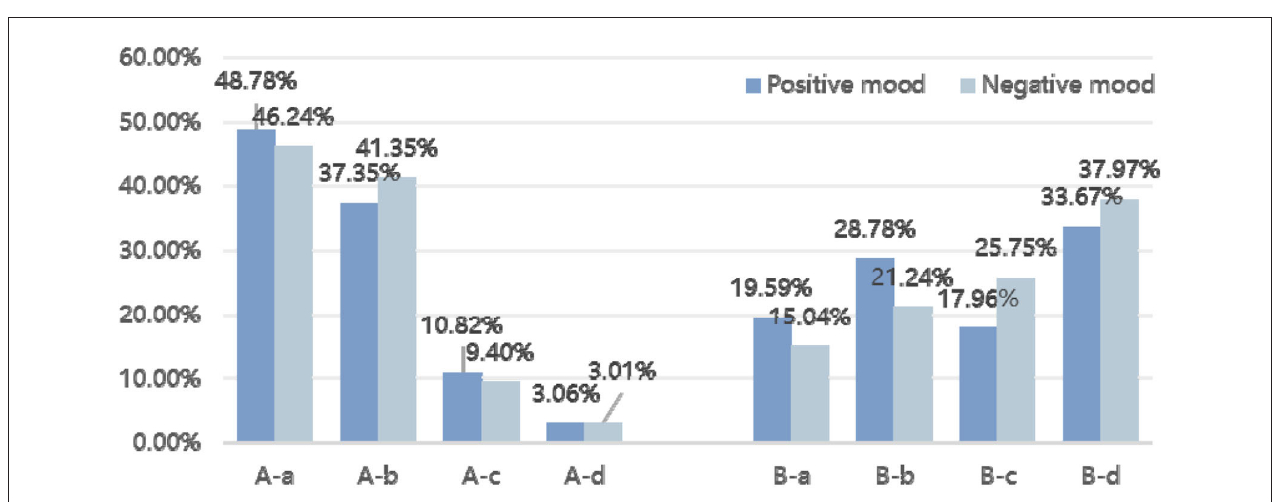
FIGURE 3 | Descriptive statistics of the landscape preference selections from the perspectives of the respondents with seven different dominant moods (this illustration is based on the percentage of the selected sample).